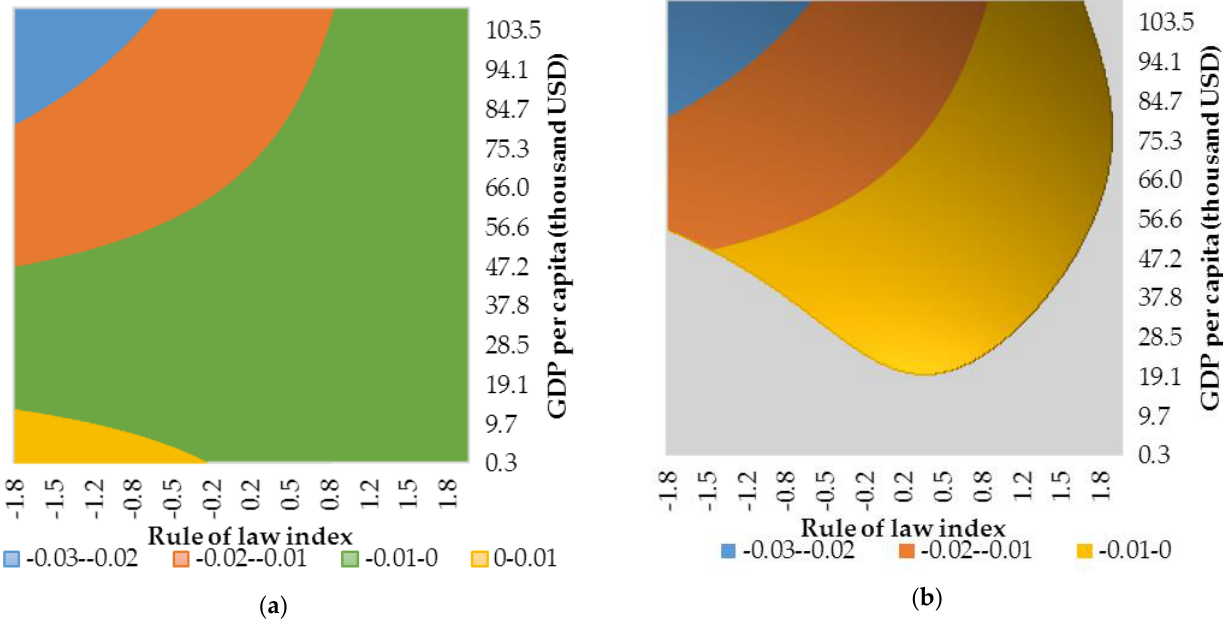
Figure A23. Conditional effect of financialisation on growth based on Est. 23 in Table A2. ( a ) Estimated conditional slope coefficient over the whole range of observed values for institutional quality and development level. ( b ) Estimated statistically significant conditional slope coefficient. Gray represents a combination of institutional quality and development level for which effect of financialisation on growth is statistically insignificant. Source: authors’ contributions.